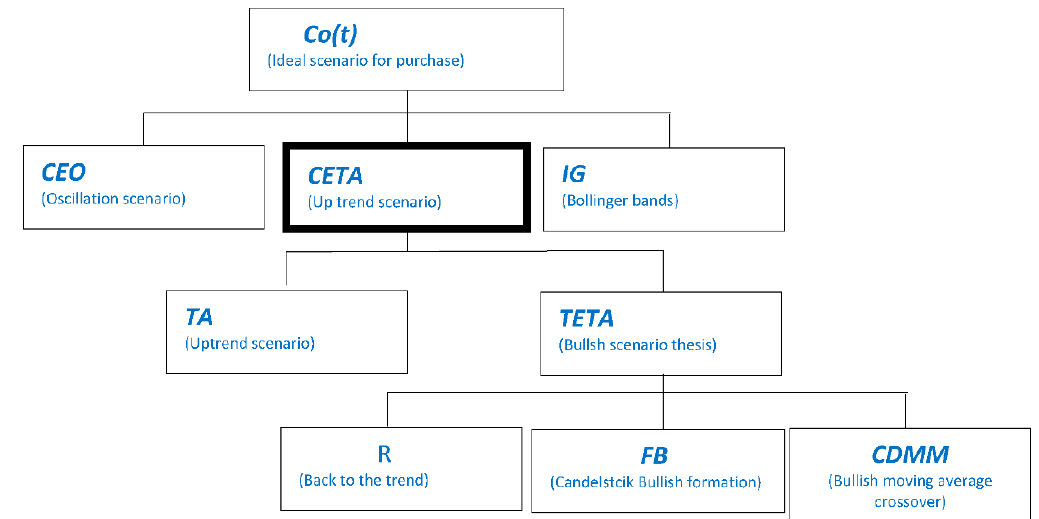
Figure 3. Evaluation of “there is a bullish scenario”.